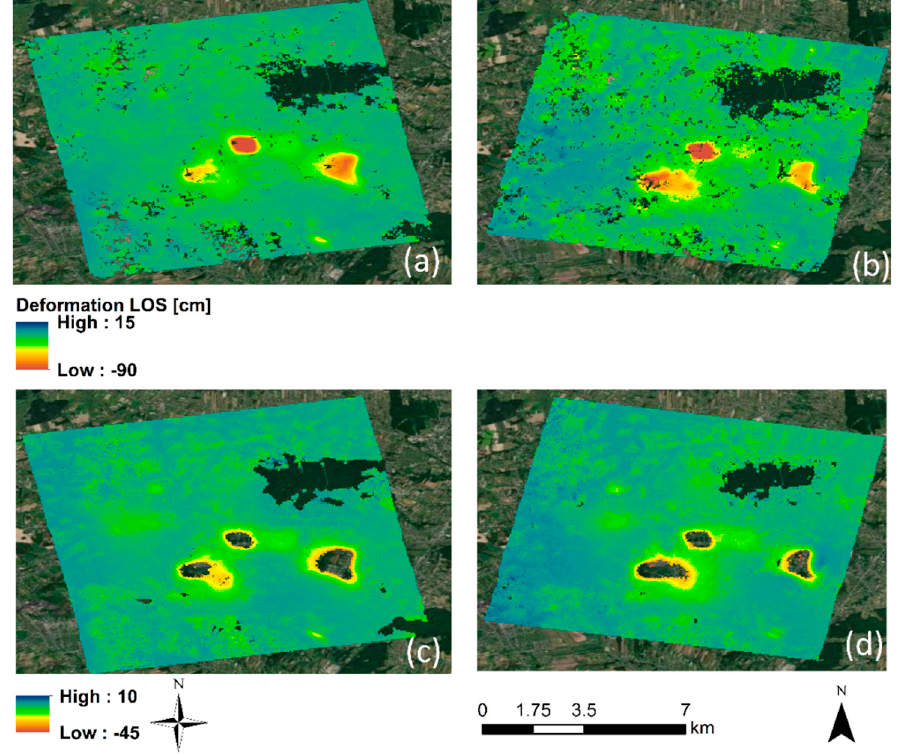
Figure 5. SBAS and DInSAR deformation results from the DInSAR ( a , b ) and SBAS ( c , d ) technique in the LOS direction for ascending ( a , c ) and descending ( b , d ) orbit.